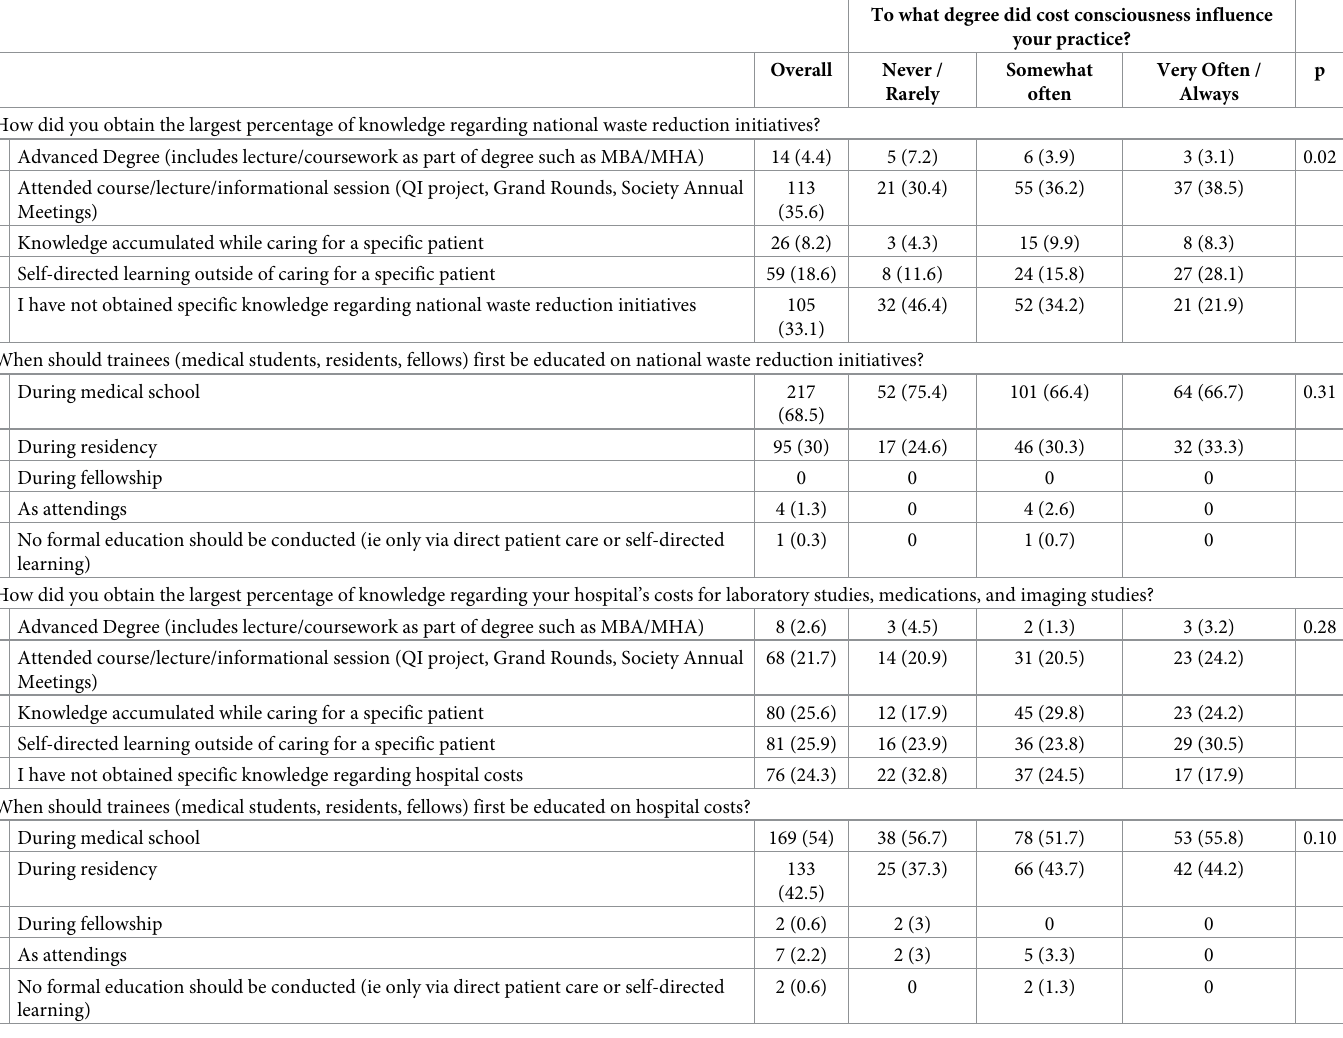
Table 3. Self-reported knowledge of national medical waste reduction initiatives and hospital